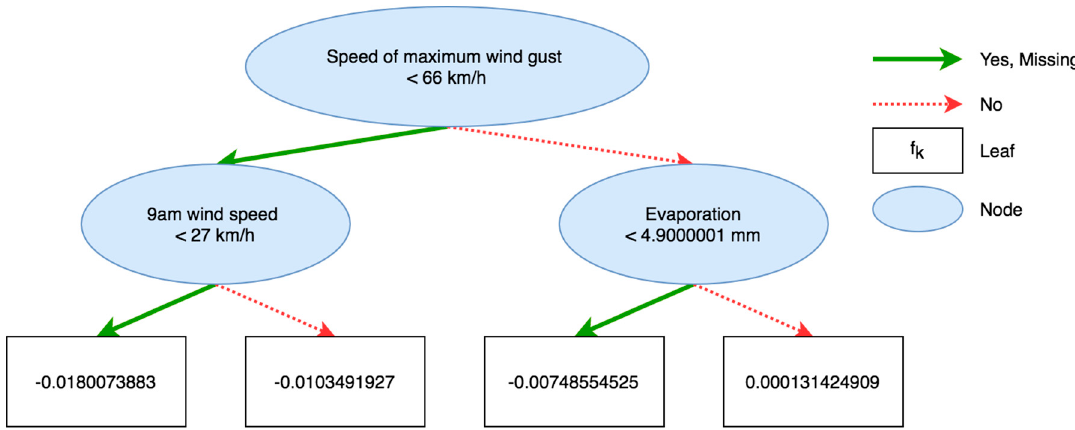
Figure 2. Example of CART prediction.